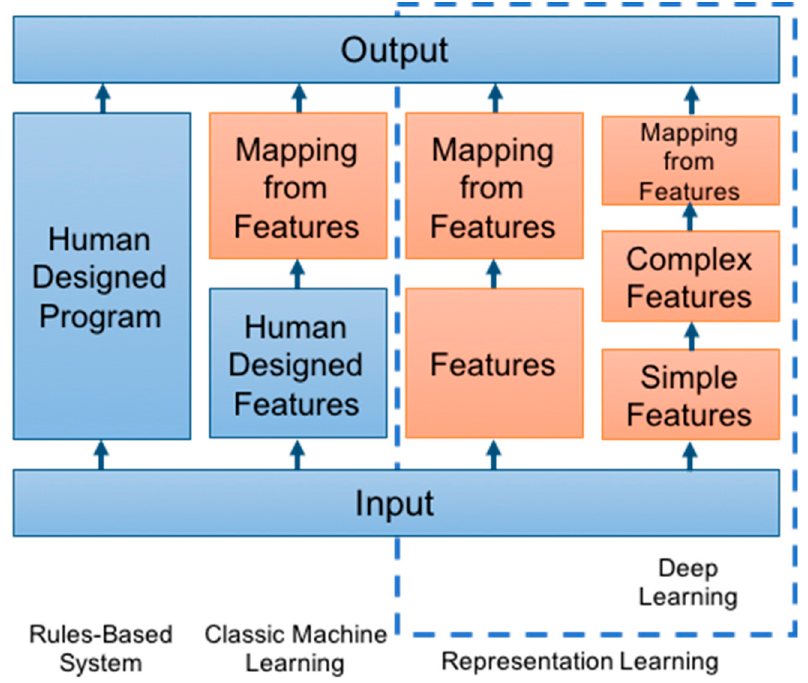
Figure 1. Adapted from Goodfellow et al. [7]. Flowchart of the varying machine learning components across different disciplines, increasing in sophistication from left to right. Orange boxes denote trainable components.